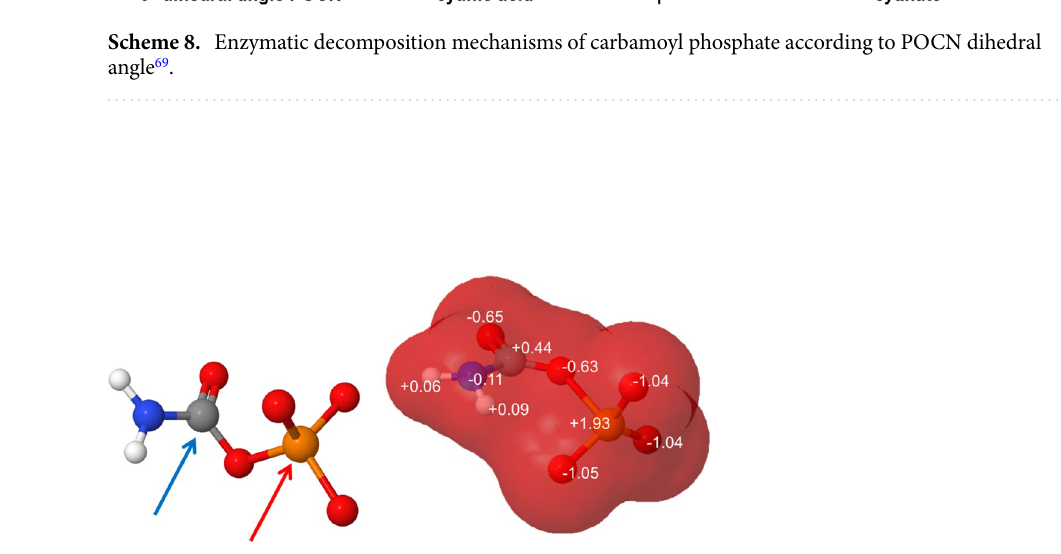
Figure 4. ( a ) Potential electrophilic sites on carbamoyl phosphate ( b ) Calculated charge distribution on carbamoyl